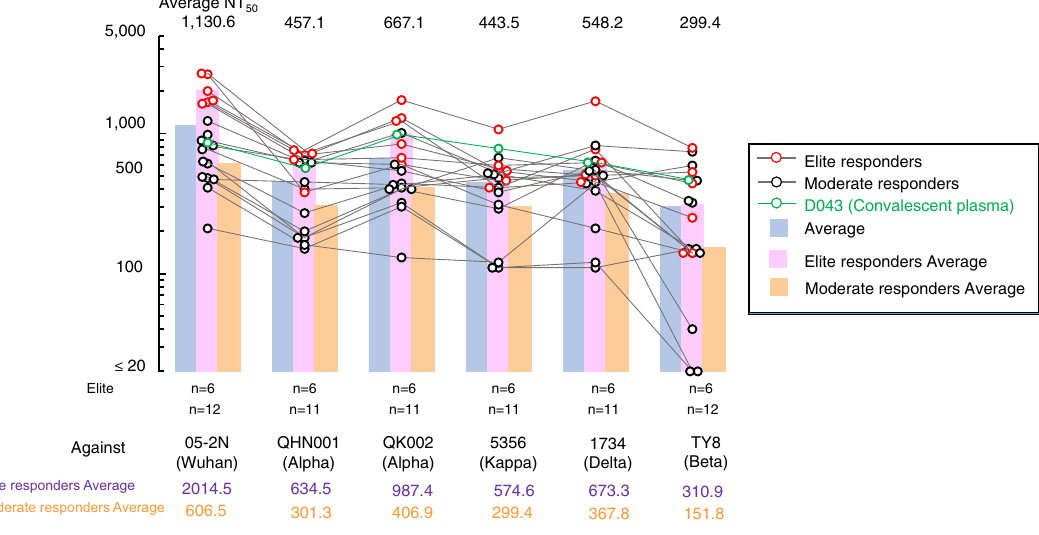
Figure 4. Blockade of the infectivity and replication of SARS-CoV-2 variants by vaccinees’ sera on day 28 post-1st dose. The activity of vaccinees’ sera to block the infectivity and replication of 5 SARS-CoV-2 variants (alpha variants: SARS-CoV-2 QHN001 and SARS-CoV-2 QK002 ; a beta strain: SARS-CoV-2 TY8-612 ; a delta strain: SARS-CoV-2 1734 ; and a kappa strain: SARS-CoV-2 5356 ) was evaluated. A Wuhan strain SARS-CoV-2 05-2 N 41 was employed as a reference SARS-CoV-2. Six sera were from elite responders (NT 50 > 1,500) and 12 sera were from randomly-selected moderate responders (NT 50 = 200 ~ 1,500). The NT 50 titers of each sera against 6 SARS-CoV-2 strains are shown in red circles (for 6 elite responders) and in black circles (for 12 moderate responders). D043 is a sera from a COVID-19-convalescent patient 43 and served as an internal control in the assays. P values for the difference between the averages of elite and moderate responders in each variant: < 0.001 (05-2 N), 0.006 (QHN001), 0.004 (QK002), 0.035 (5356), 0.119 (1734), and